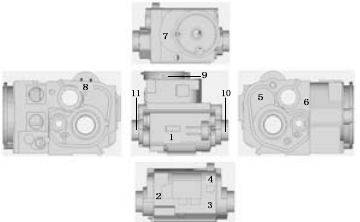
Fig.19. The arrangement of measured